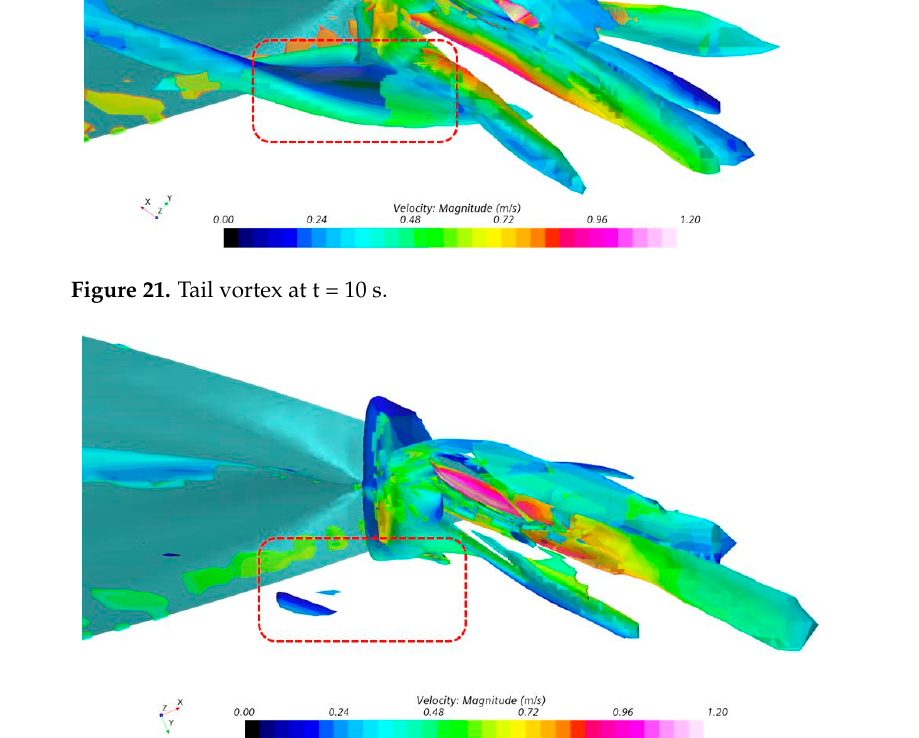
Figure 22. Tail vortex at t = 40 s.